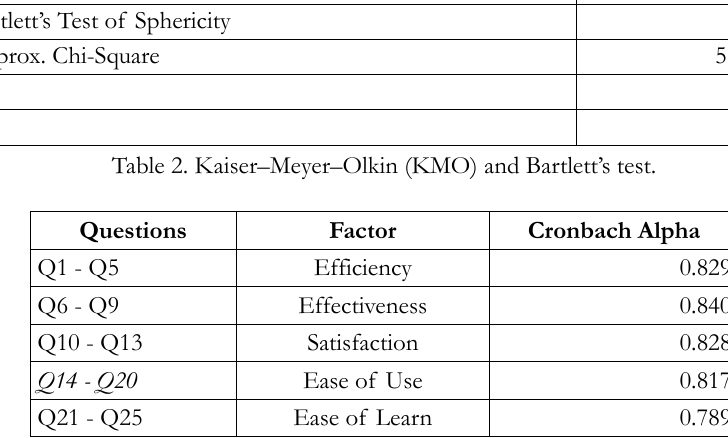
Table 3. Cronbach